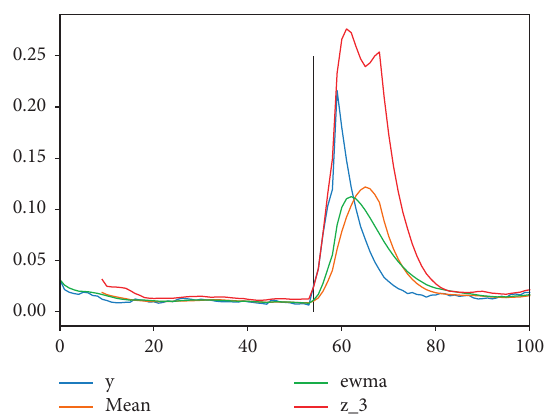
Figure 10: The diagnostic results of abnormal bearing